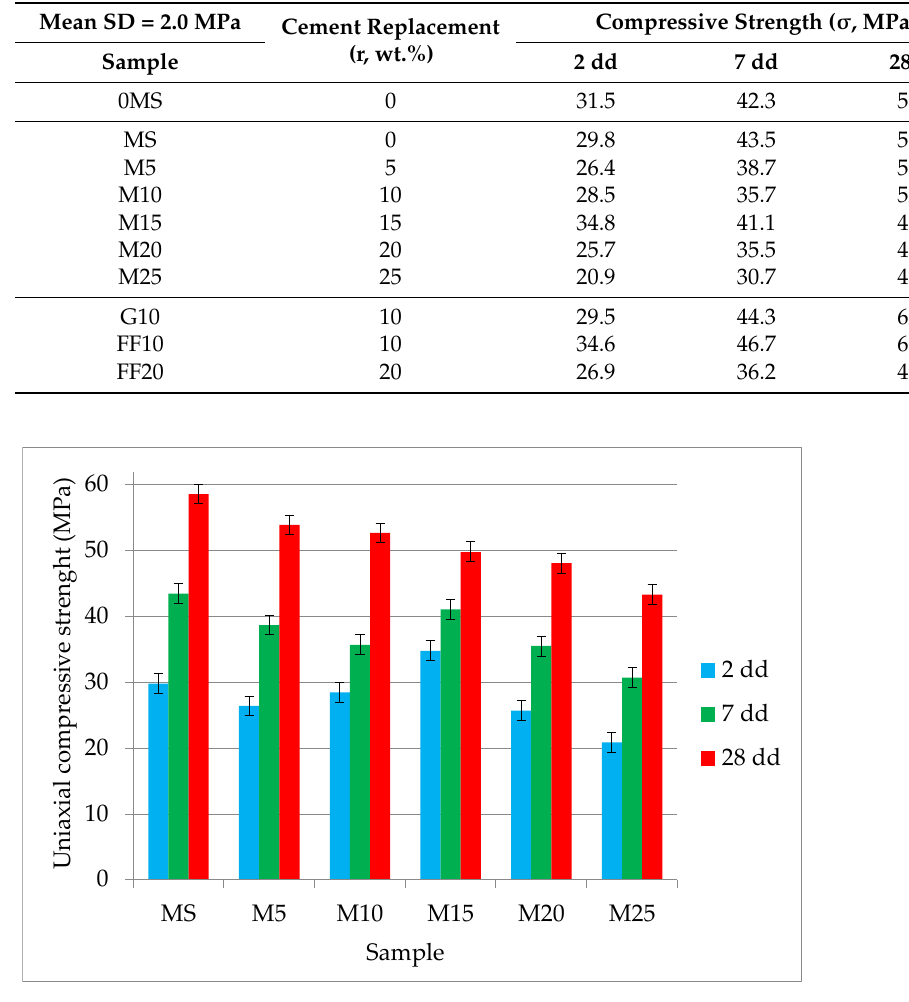
Figure 6. Compressive strength histogram of the specimens MS, M5, M10, M15, M20, and M25 mixtures at 2, 7, and 28 days of curing.